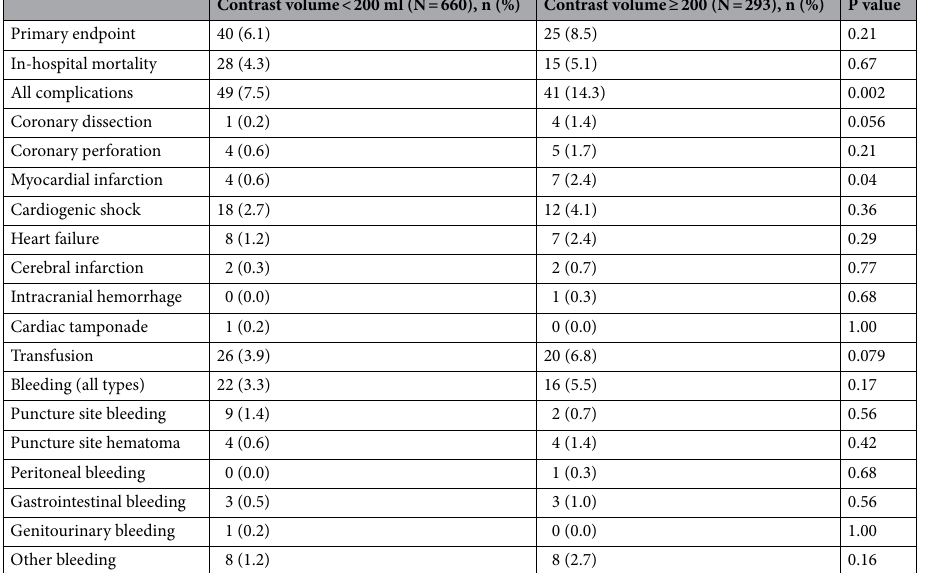
Table 2. In-hospital mortality and complications.